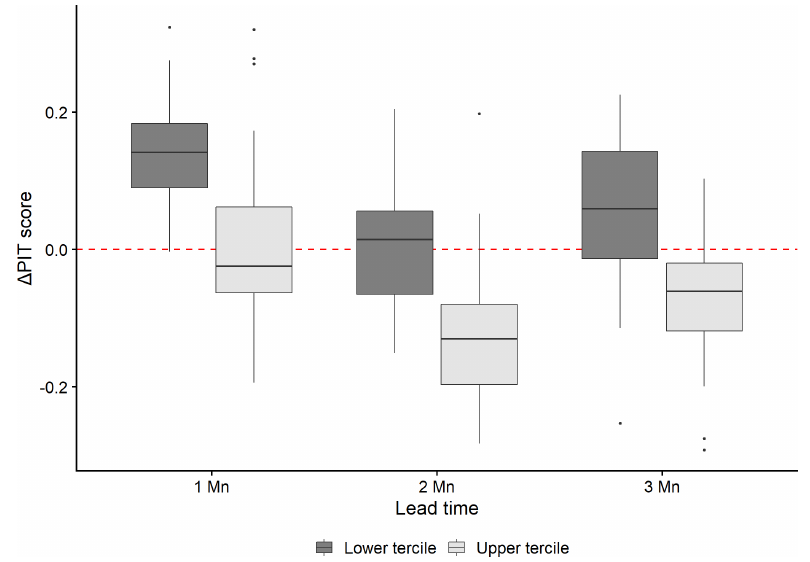
Figure 11. Difference in PIT score values between NAO-conditioned ESP and historical ESP at lead times of 1, 2, and 3 months. Negative values indicate a reduction in reliability, whereas positive values indicate an increase in reliability over historical